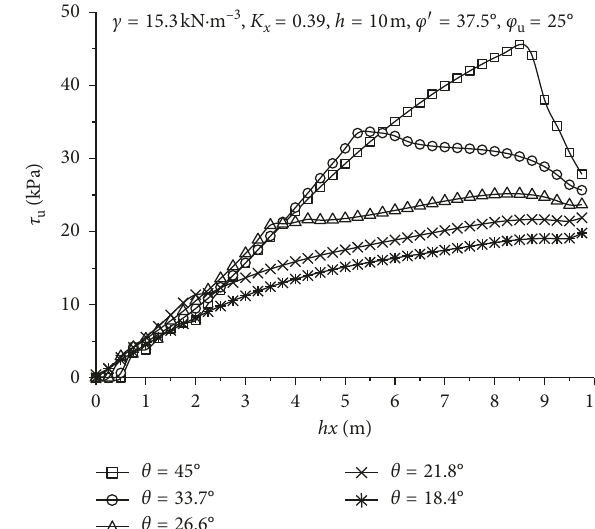
Figure 8: Interface normal stress distribution.